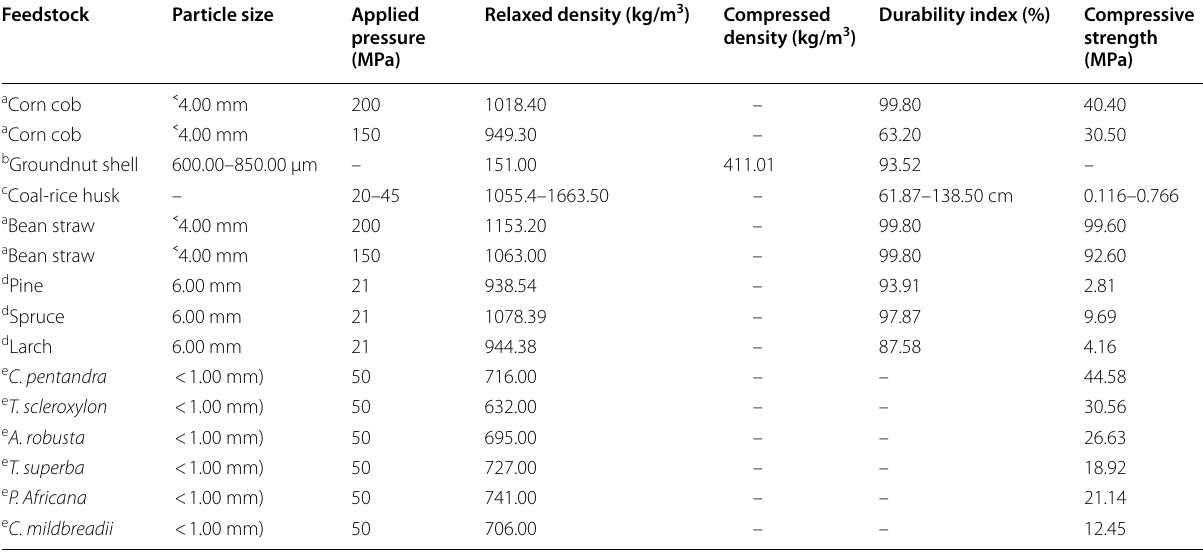
Table 4 Effect of particle size and applied pressure on some physical and mechanical properties of briquettes produced from selected agricultural and forestry